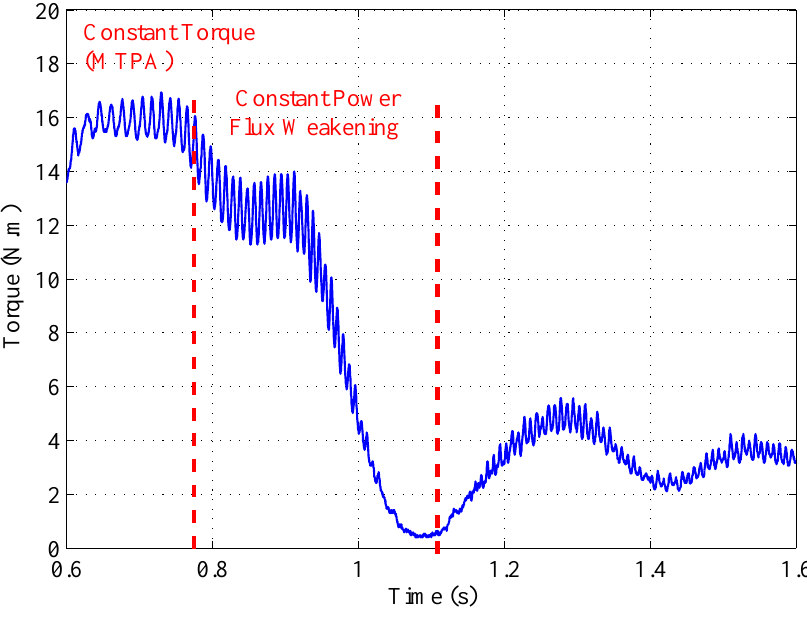
Figure 4. Transient characteristics of control